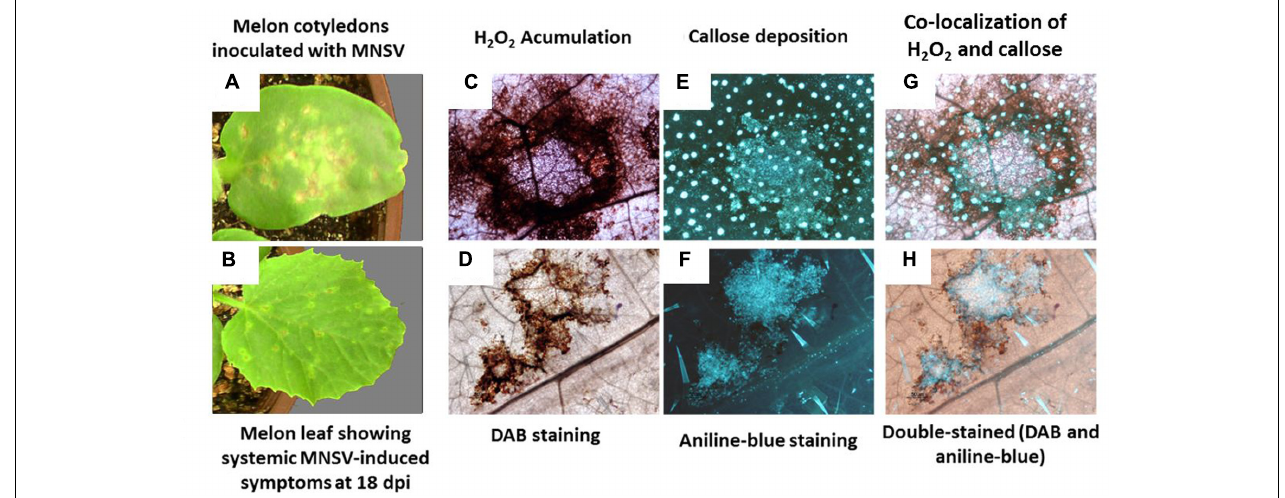
FIGURE 1 | Melon necrotic spot virus (MNSV) symptoms in inoculated cotyledons and systemically infected leaves. Localisation of H 2 O 2 and callose deposition. Cucumis melo plants were infected by the mechanical inoculation of fully expanded cotyledons with purified virions of an MNSV-Al isolate. (A) Typical MNSV necrotic lesions in the inoculated cotyledons at 5 dpi. (B) Necrotic lesions in systemic leaves at 18 dpi. (C,E) Localisation of H 2 O 2 accumulation and callose deposition, respectively, in inoculated cotyledons at 5 dpi. (G) Co-localisation of H 2 O 2 and callose deposition at infection sites. (D) Localisation of H 2 O 2 accumulation and (F) callose deposition in the MNSV-infected leaves at 18 dpi. (H) Co-localisation of H 2 O 2 and callose deposition in the systemically infected leaves at 18 dpi.